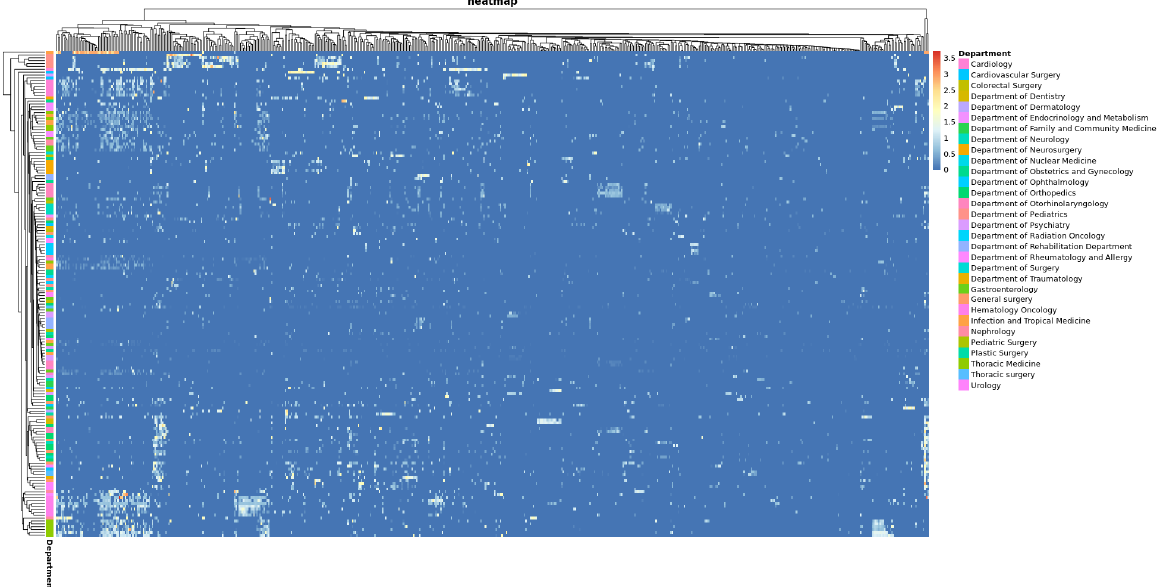
Figure 3. MAE heat map of LMM-modified LSTM prediction scores from scoring and scored physicians. X -axis: physicians who wrote the medical records; Y -axis: scoring physicians and their departments. By subtracting the MAE of the original score from the LMM modified LSTM prediction score, and using the MAE and coring physicians to conduct a heat map analysis, it can be found that some reviewer scores are on the high side.